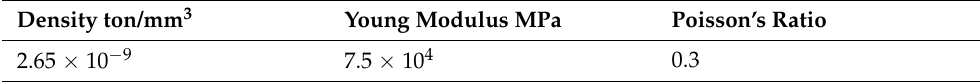
Table 1. *MAT_ELASTIC.